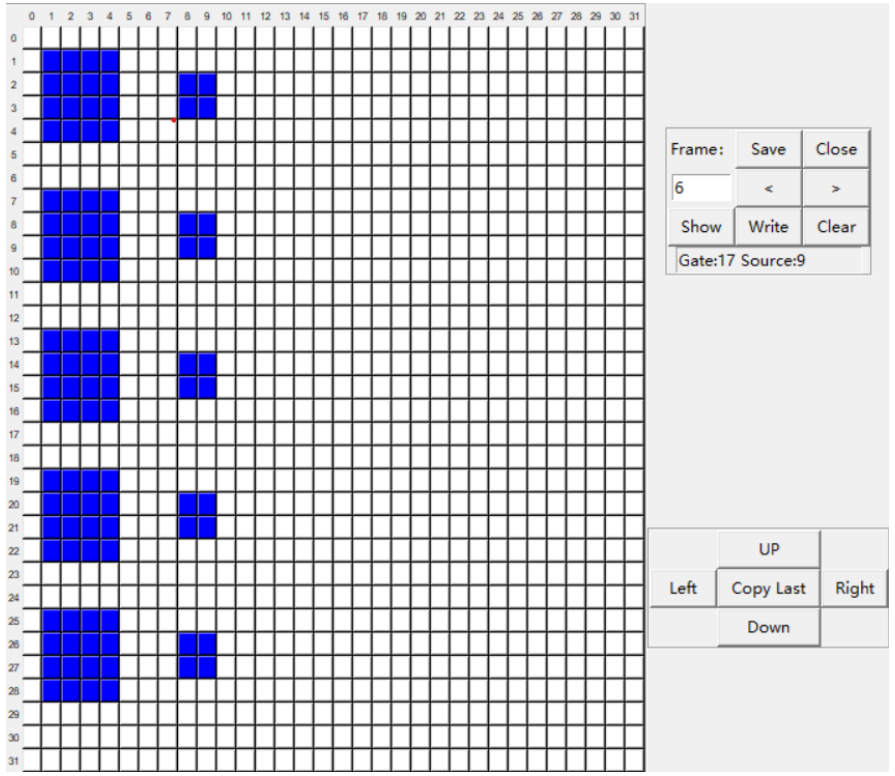
Figure 8. Interface of the software to control the manner of the manipulation of droplets